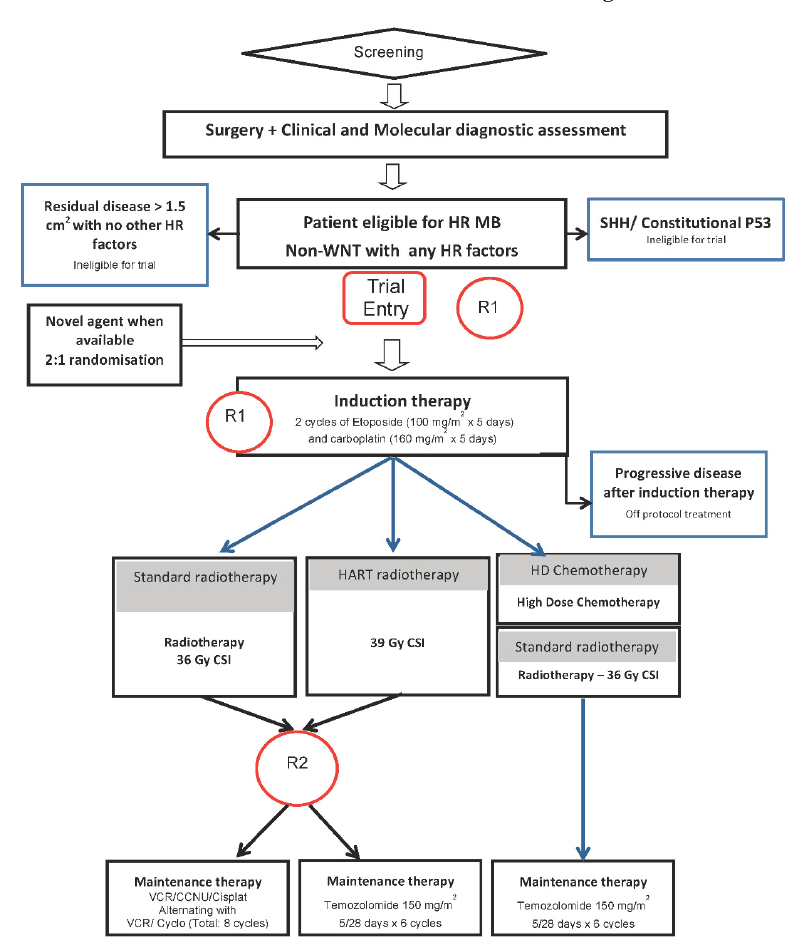
Figure 1. Schema for the SIOP-Europe high-risk medulloblastoma (SIOP-HR-MB) clinical trial. R1: Randomisation 1. To be performed at trial entry after screening. R2: Randomisation 2. To be performed after completion of radiotherapy and within 7 days prior to the planned start of maintenance therapy. Patients who are not eligible for further protocol therapy are advised to be treated in accordance with the current national guidelines.